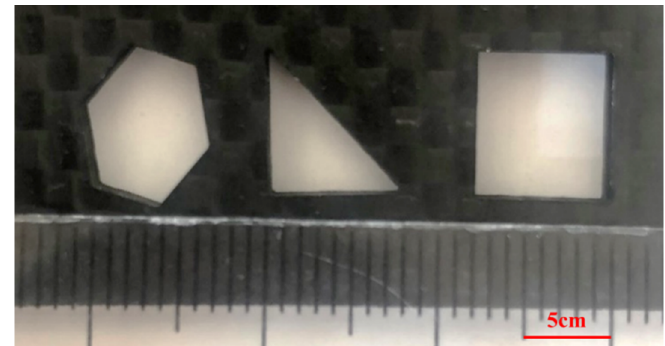
Figure 6. CFRP laser cutting holes with different shapes.